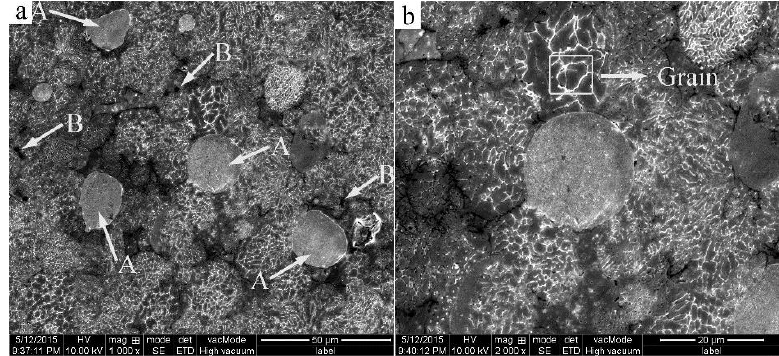
Figure 3. SEM micrographs of the cold-pressed bulk alloy. ( a ) Low magnification; ( b ) High magnification.